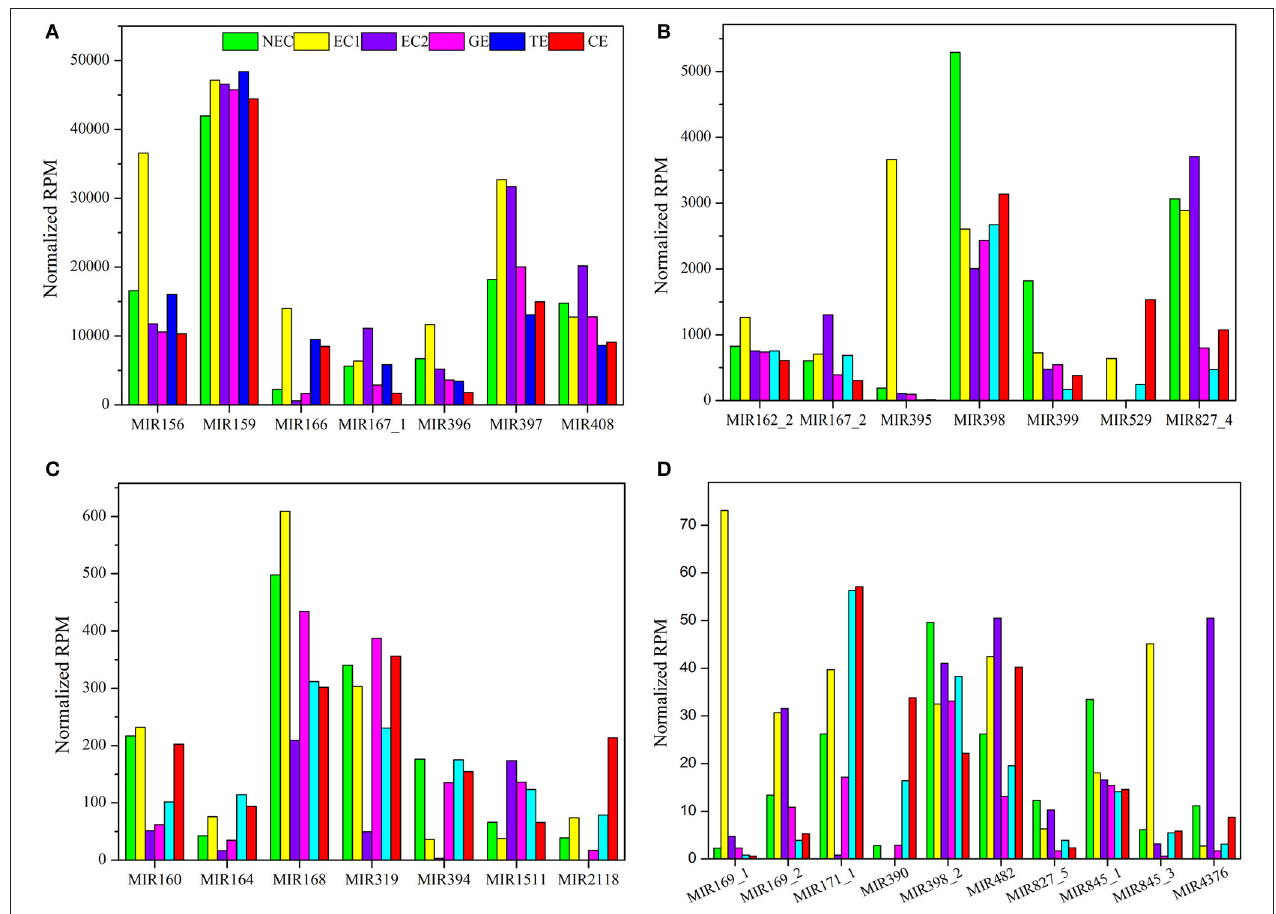
FIGURE 4 | Reads per million known miRNAs in Lilium pumilum DC. Fisch. (A) miRNA families with highest expression abundance over 10,000 RPM; (B) miRNA families with highest expression abundance between 1,000 and 10,000 RPM; (C) miRNA families with highest expression abundance between 100 and 1,000 RPM; (D) miRNA families with highest expression abundance between 10 and 100